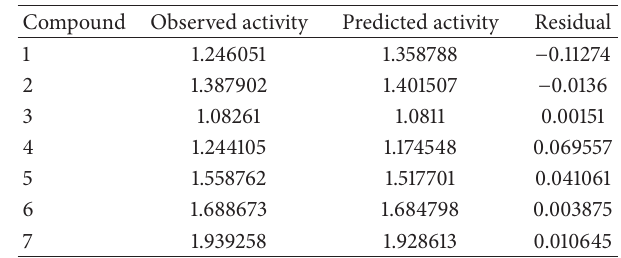
Table 7: Observed and predicted antibacterial activity of synthe- sized substituted benzamide Mannich bases against Pseudomonas aeruginosa .